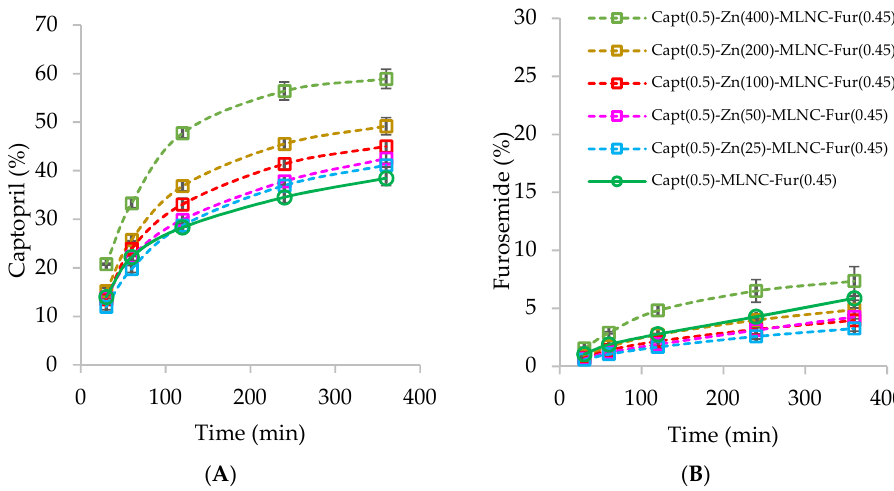
Figure 1. Dialysis in water for 6 h of formulations: Capt(0.5)-MLNC-Fur(0.45) prepared without Zn 2+ and Capt(0.5)-Zn-MLNC-Fur(0.45) prepared using increased Zn 2+ concentrations (25, 50, 100, 200 and 400 μg mL −1 ). A : dialysis of captopril and B : dialysis of furosemide. Legend for both graphics is shown in B.